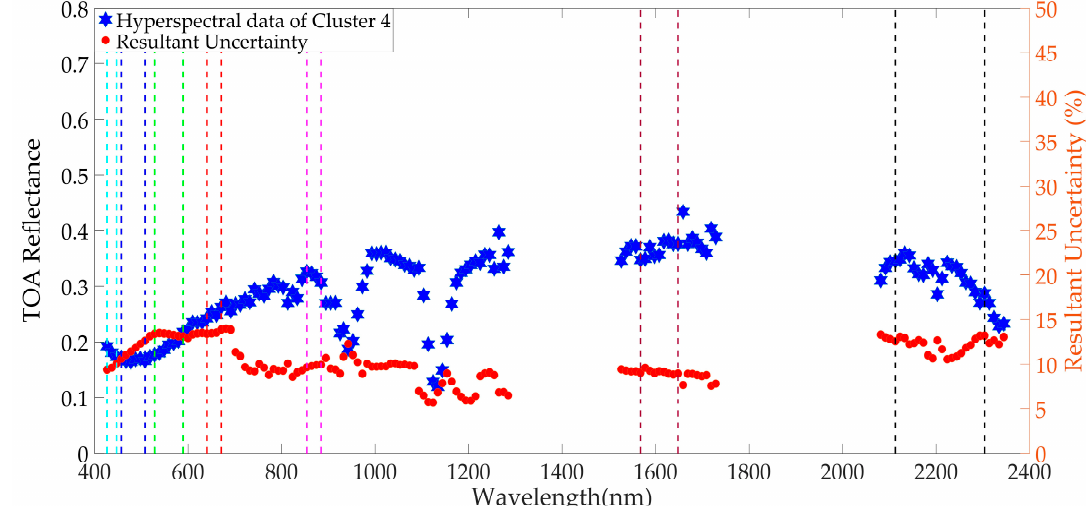
Figure 15. Estimated representative hyperspectral profile of Cluster 4 and its resultant uncertainty.